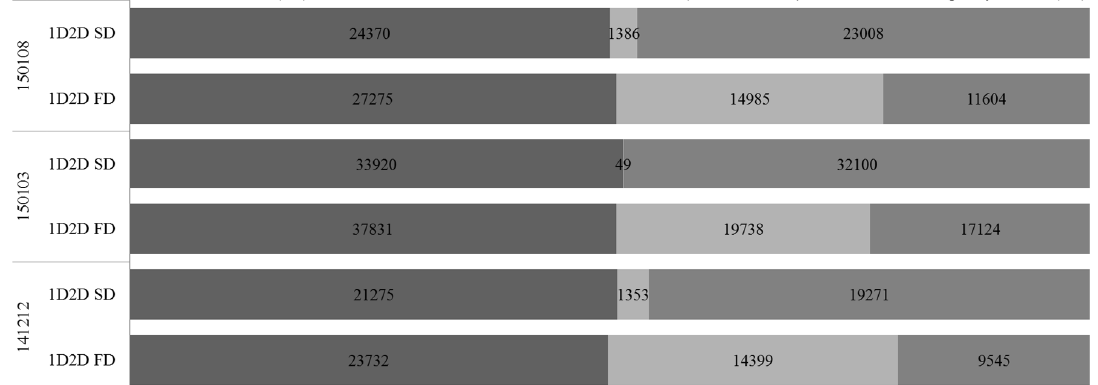
Figure 6. Volume balance for the Cranbrook case study model runs.